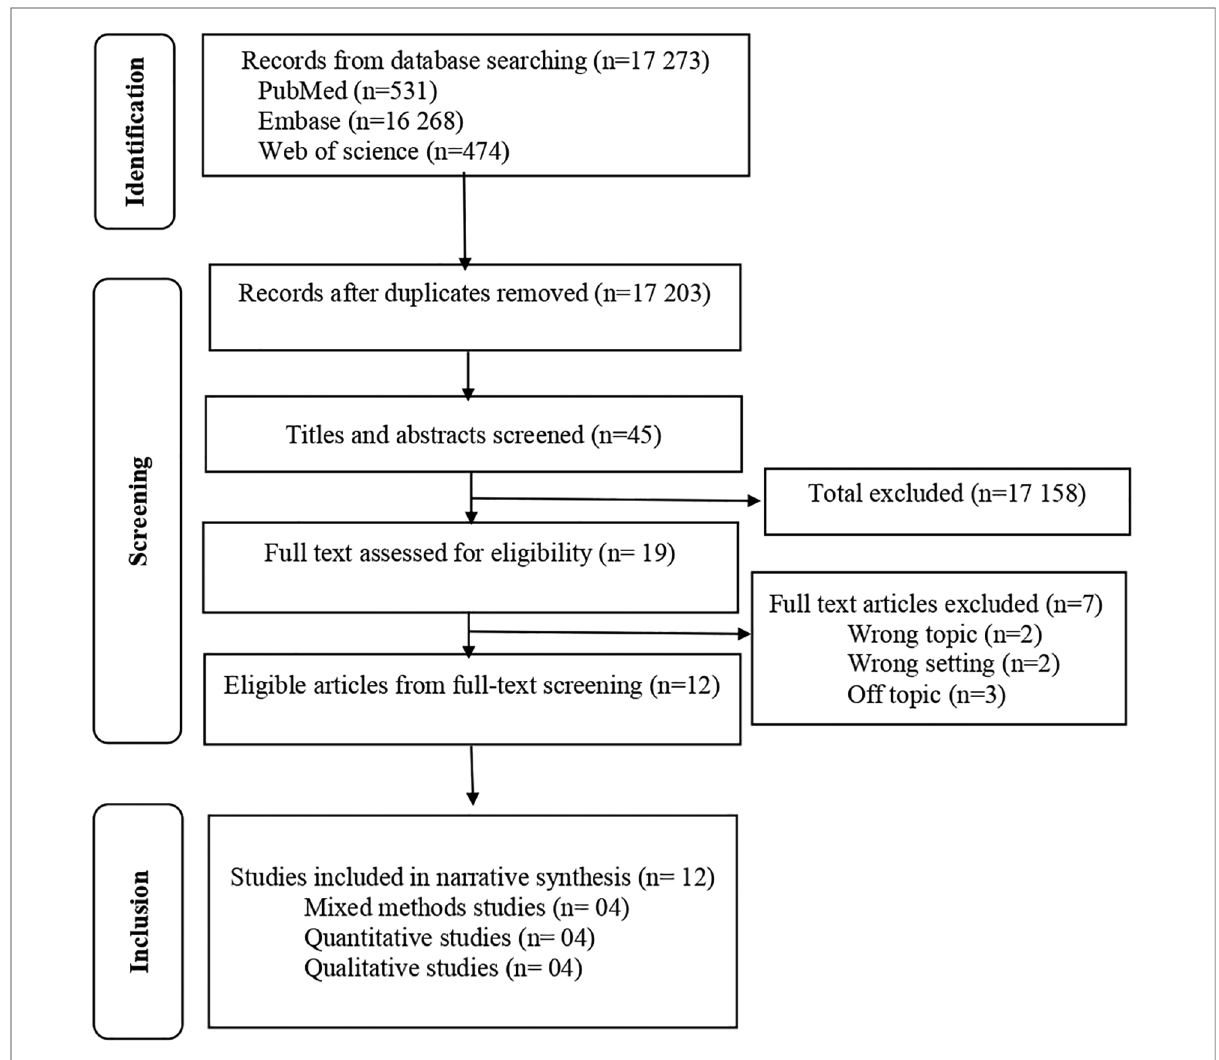
FIGURE 2 PRISMA fl owchart. The selection process for the systematic review of barriers and facilitators for the sustainability of digital